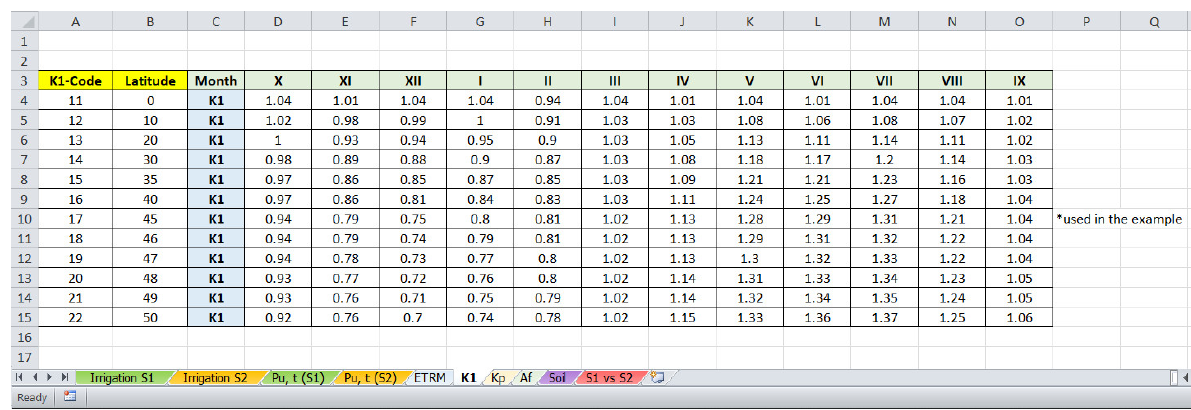
Figure 6. The “ETRM” worksheet.